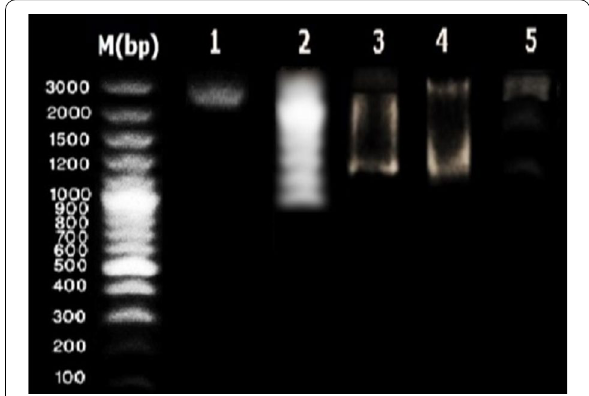
Fig. 2 Genomic DNA fragmentation pattern of liver tissues on 1% agarose gel electrophoresis. LanM: DNA ladder, Lane 1: saline (negative control); Lane 2: treated with HFHF (positive control); Lane 3: treated with HFHF silymarin, Lane 4: treated with + HFHF curcumin; Lane 5: treated with HFHF + +